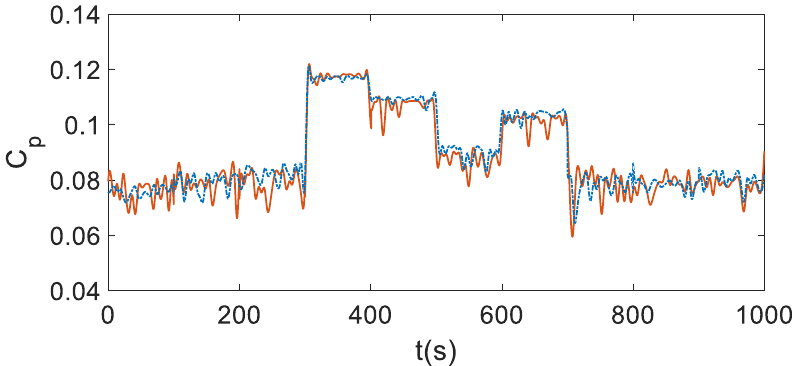
Figure 16. Power coefficient model validation of model (10) (blue dotted line) and FAST module (red solid line) under wind speed condition.